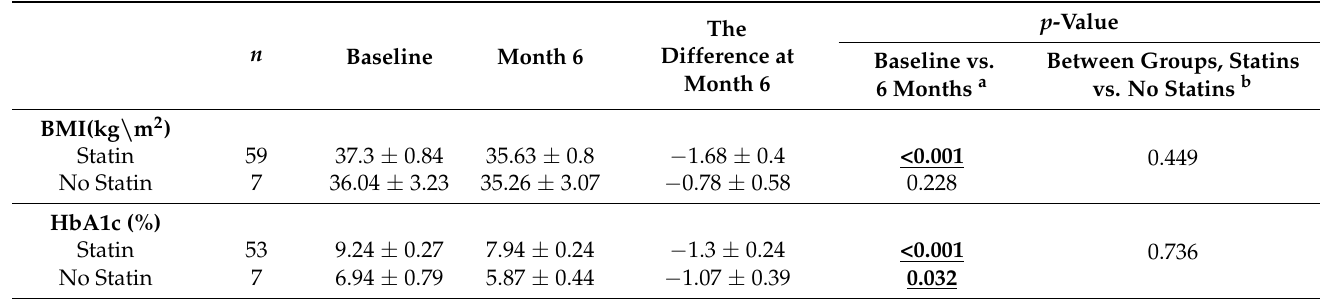
Table 3. Changes of BMI and HbA1c from the baseline in type 2 diabetes mellitus subjects treated with GLP-1RAs.